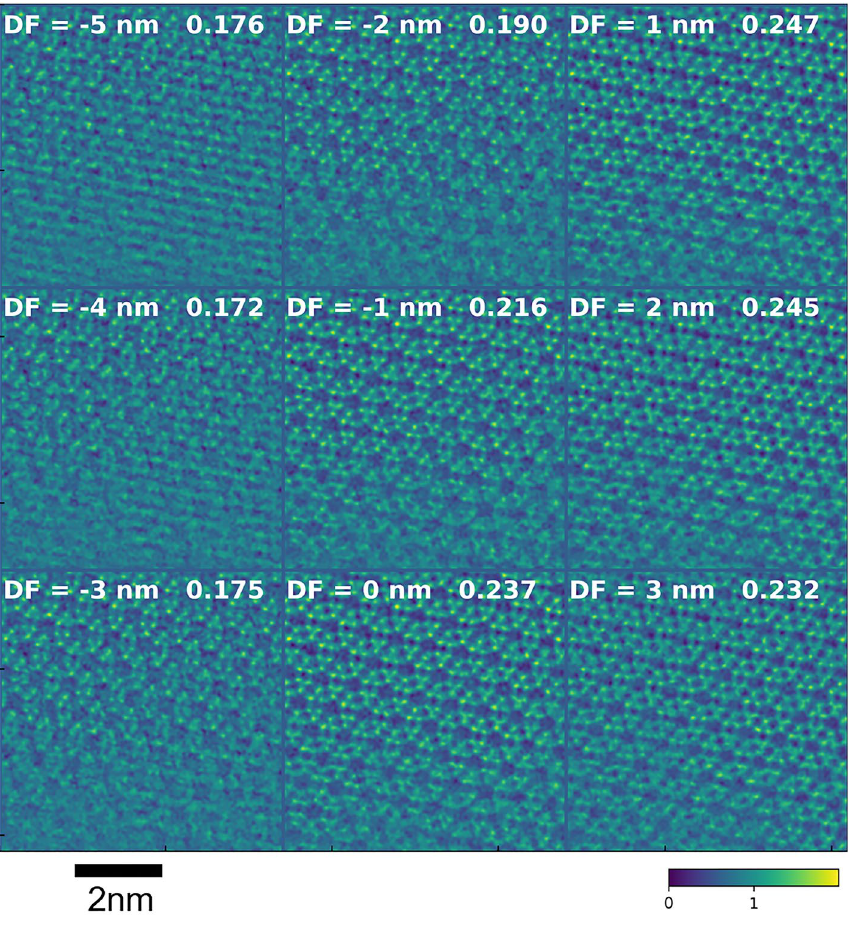
Figure 4. Experimental images of Cu-containing CHA reconstructed with defocus ranging from − 5 to 3 nm. The number at the top right of each image is the standard deviation of the